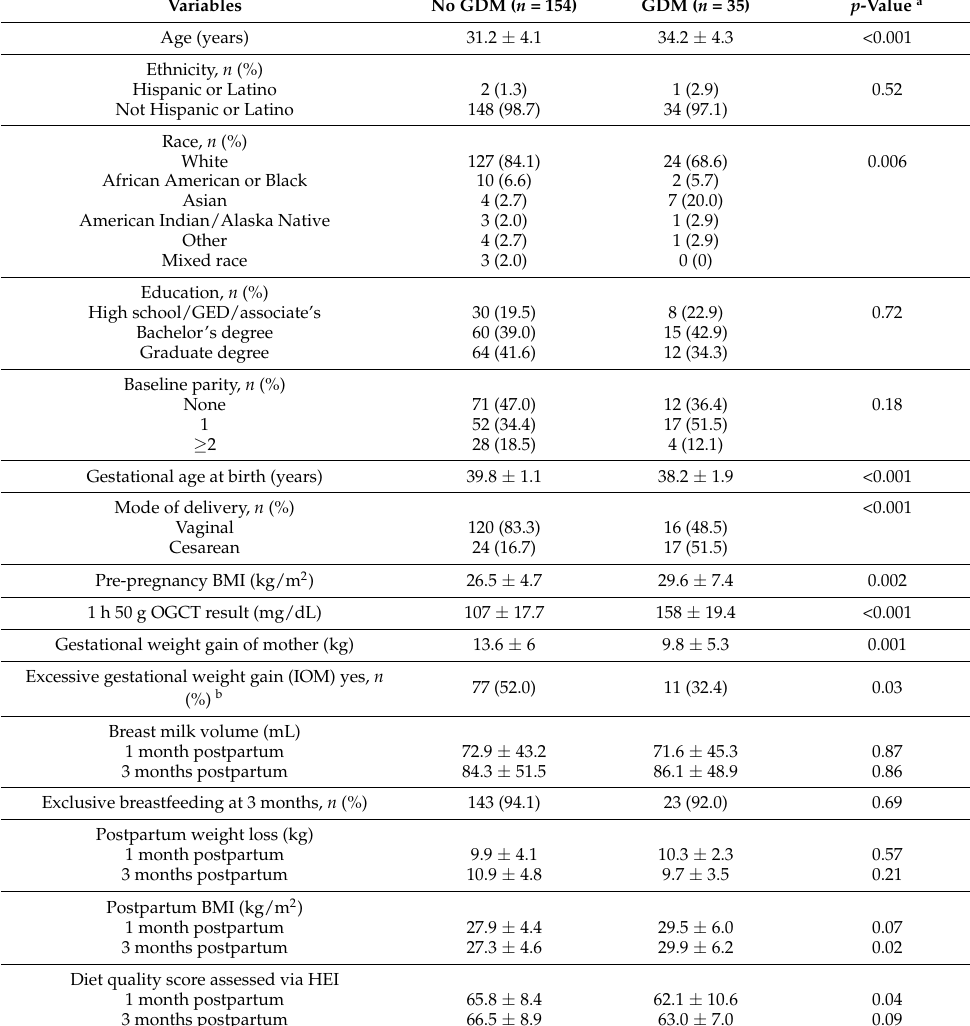
Table 1. Demographic and clinical characteristics at baseline and 1 month to 3 months postpartum according to GDM status, n =